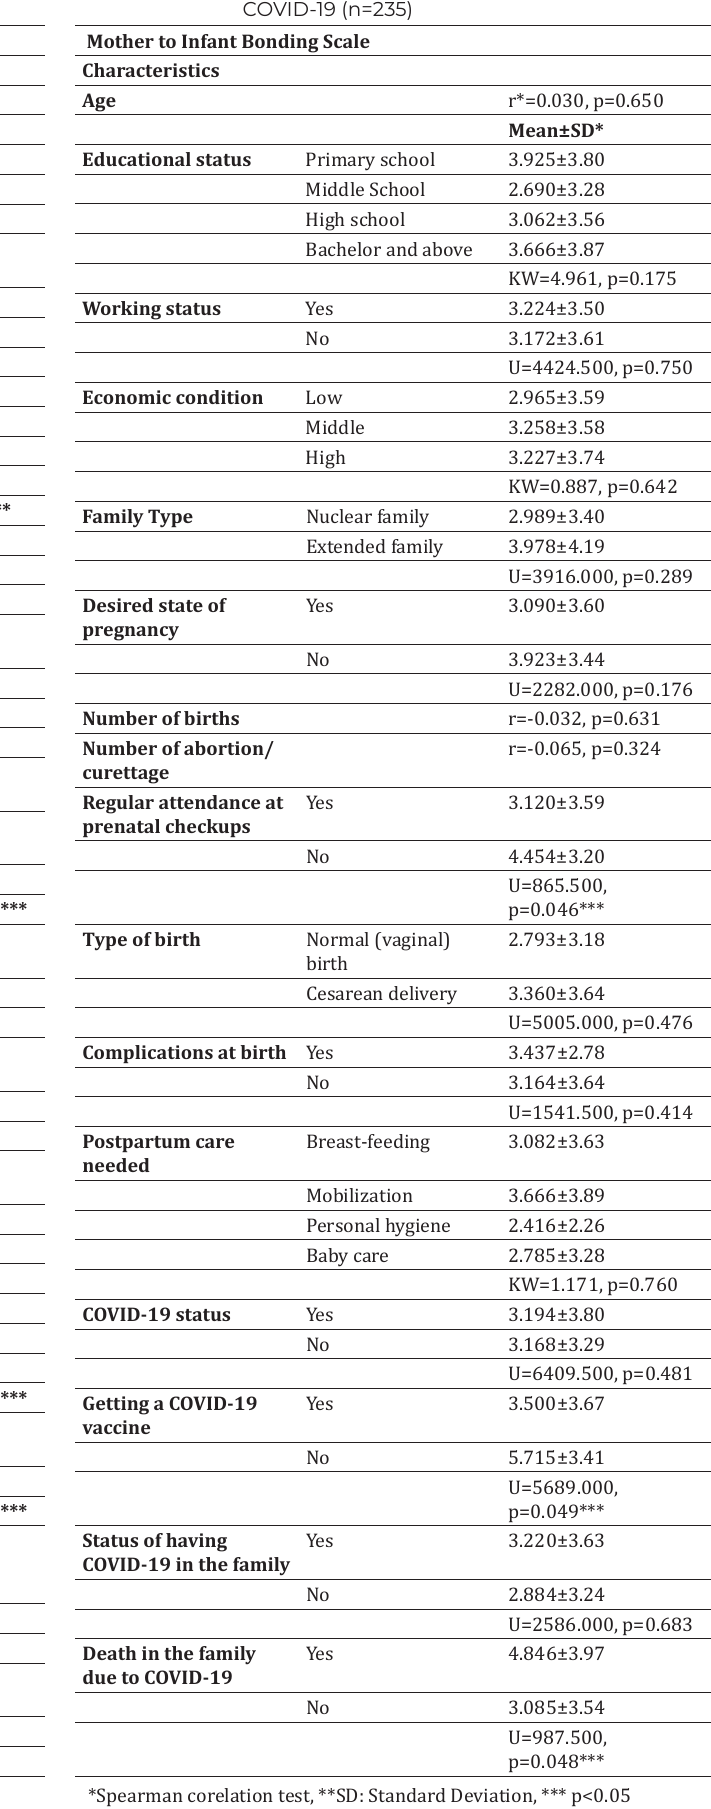
Factors Affecting the Mean Scores of the Table 4 Table 5 Fear of Coronavirus (COVID-19) Scale by Women's Socio-Demographic, Obstetrical Characteristics and Knowledge about COVID-19